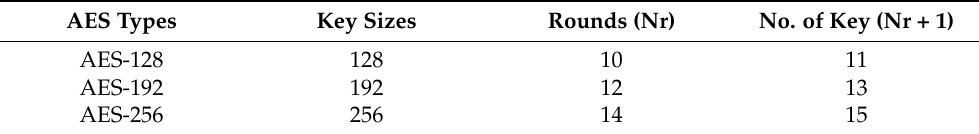
Table 1. Types of AES